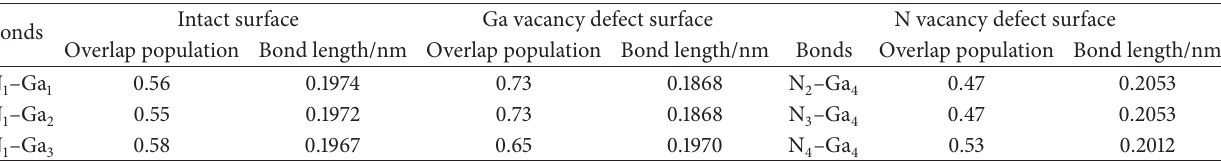
Table 2: N–Ga bond lengths and overlap populations of intact, Ga vacancy defect, and N vacancy defect surfaces. Intact surface Bonds